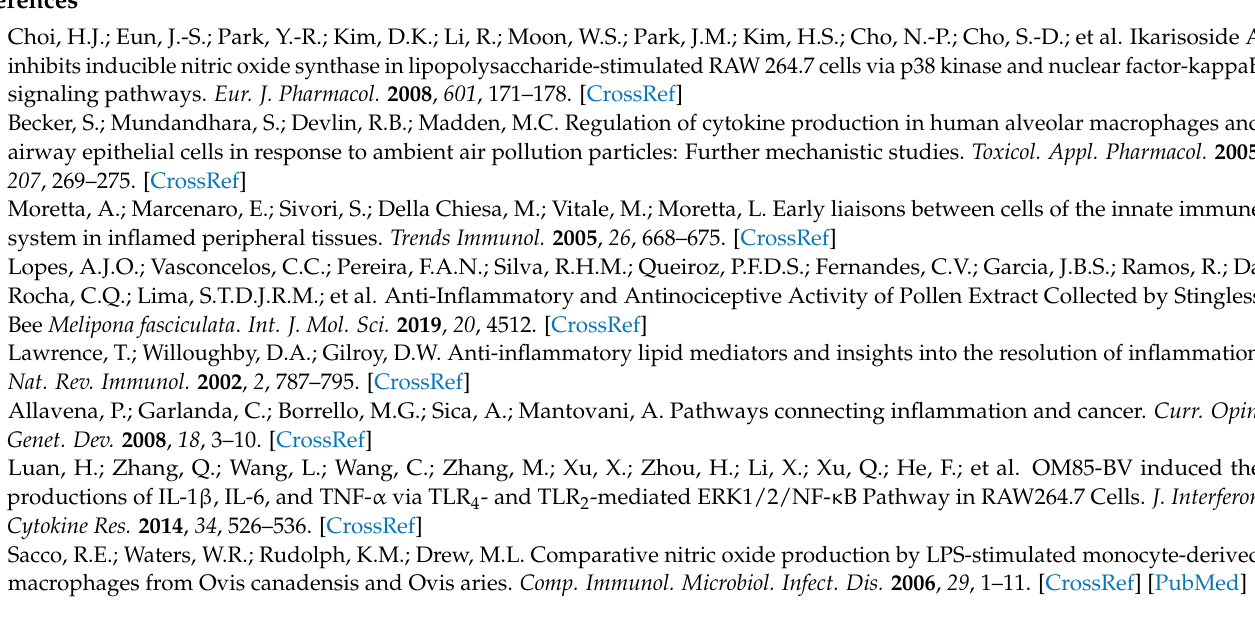
Supplementary Materials: The following are available online, Table S1: 1 H (DMSO-D 6 , 500 MHz Figure S1: 1 H NMR spectra of luteolin 3 (cid:48) - O -phosphate (LTP), Figure S2: HSQC correlation of luteolin 3 (cid:48) - O -phosphate (LTP), Figure S3: HMBC correlation of luteolin 3 (cid:48) - O -phosphate (LTP), Figure S4: COSY correlation of luteolin 3 (cid:48) - O -phosphate